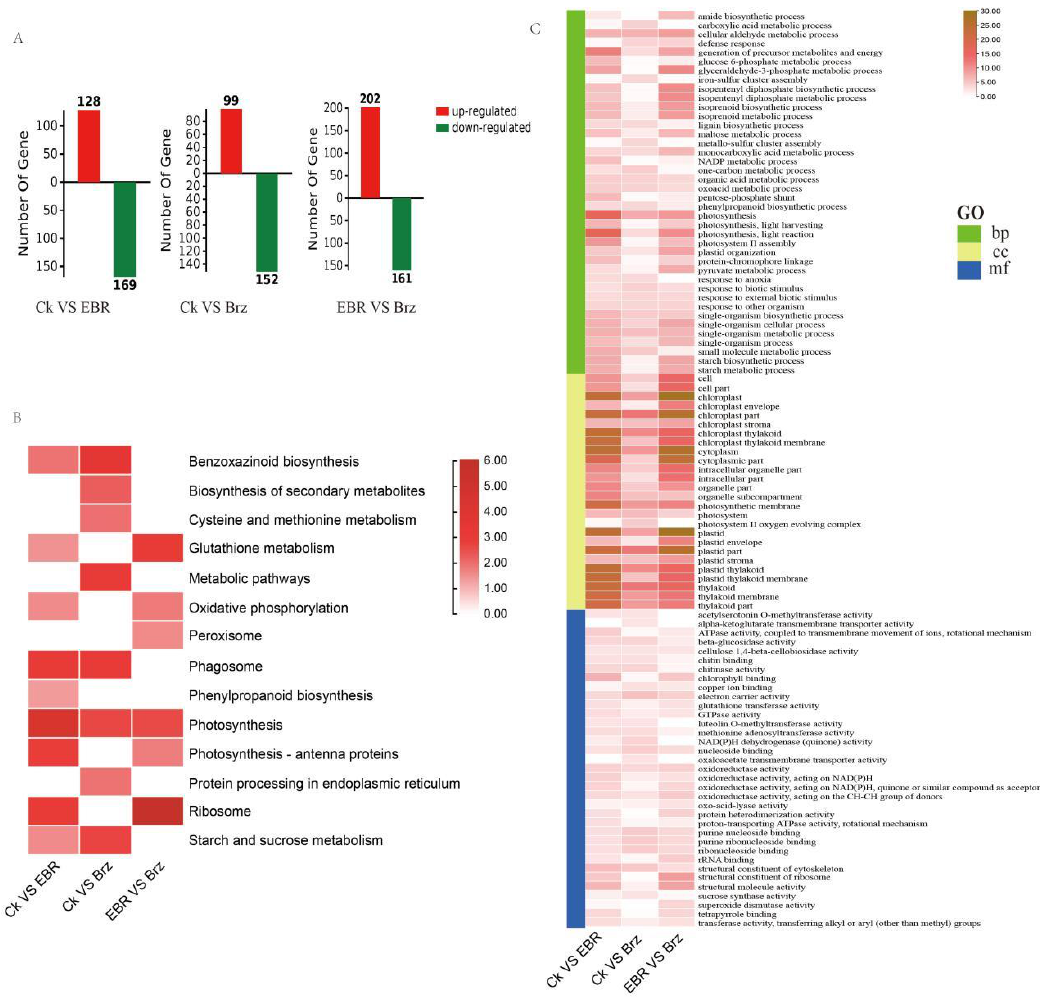
Figure 3. Enrichment analysis of BR-responsive proteome changes in maize leaves. ( A ) Statistical analysis of the number of DEPs. ( B ) The KEGG enrichment analysis of DEPs is shown as a heat map. ( C ) The GO enrichment analysis of DEPs is shown as a heat map.